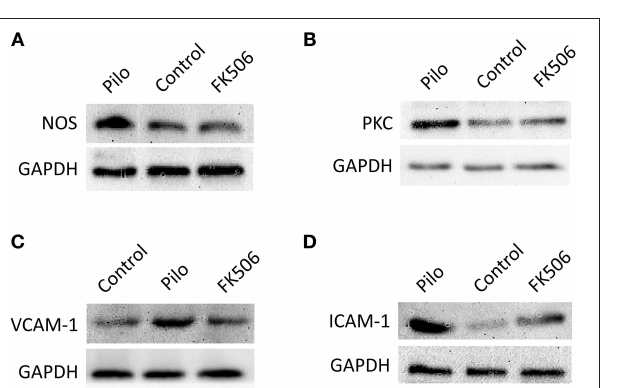
FIGURE 4 | The in situ expression of VCAM-1, ICAM-1, PKC δ , NOS, and caspase-3 in the hippocampus of different treatment groups. (A–C) NOS expression in the control group, epilepsy group, and FK506 group after 6h of modeling. (D–F) PKC δ expression in the control group, epilepsy group, and FK506 group after 6h of modeling. (G–I) VCAM-1 expression in the control group, epilepsy group, and FK506 group after 24h of modeling. (J–L) ICAM-1 expression in the control group, epilepsy group, and FK506 group after 24h of modeling. Magnification: 400 X. Red arrow, CA3 region. Black arrow, vascular endothelium.